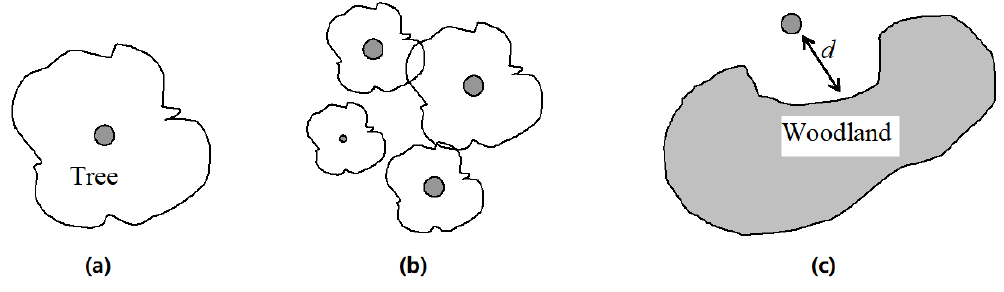
Figure 2. The dilemma in conceptualizing a woodland. ( a ) A single tree is clearly not a piece of woodland. ( b ) A woodland consists of a number of trees with a certain density. ( c ) Whether a tree belongs to a woodland depends on the distance between this particular tree and other